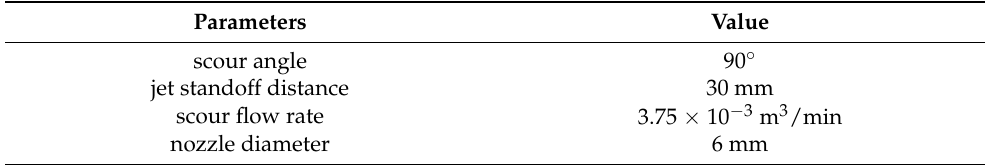
Table 3. Experimental restriction conditions.